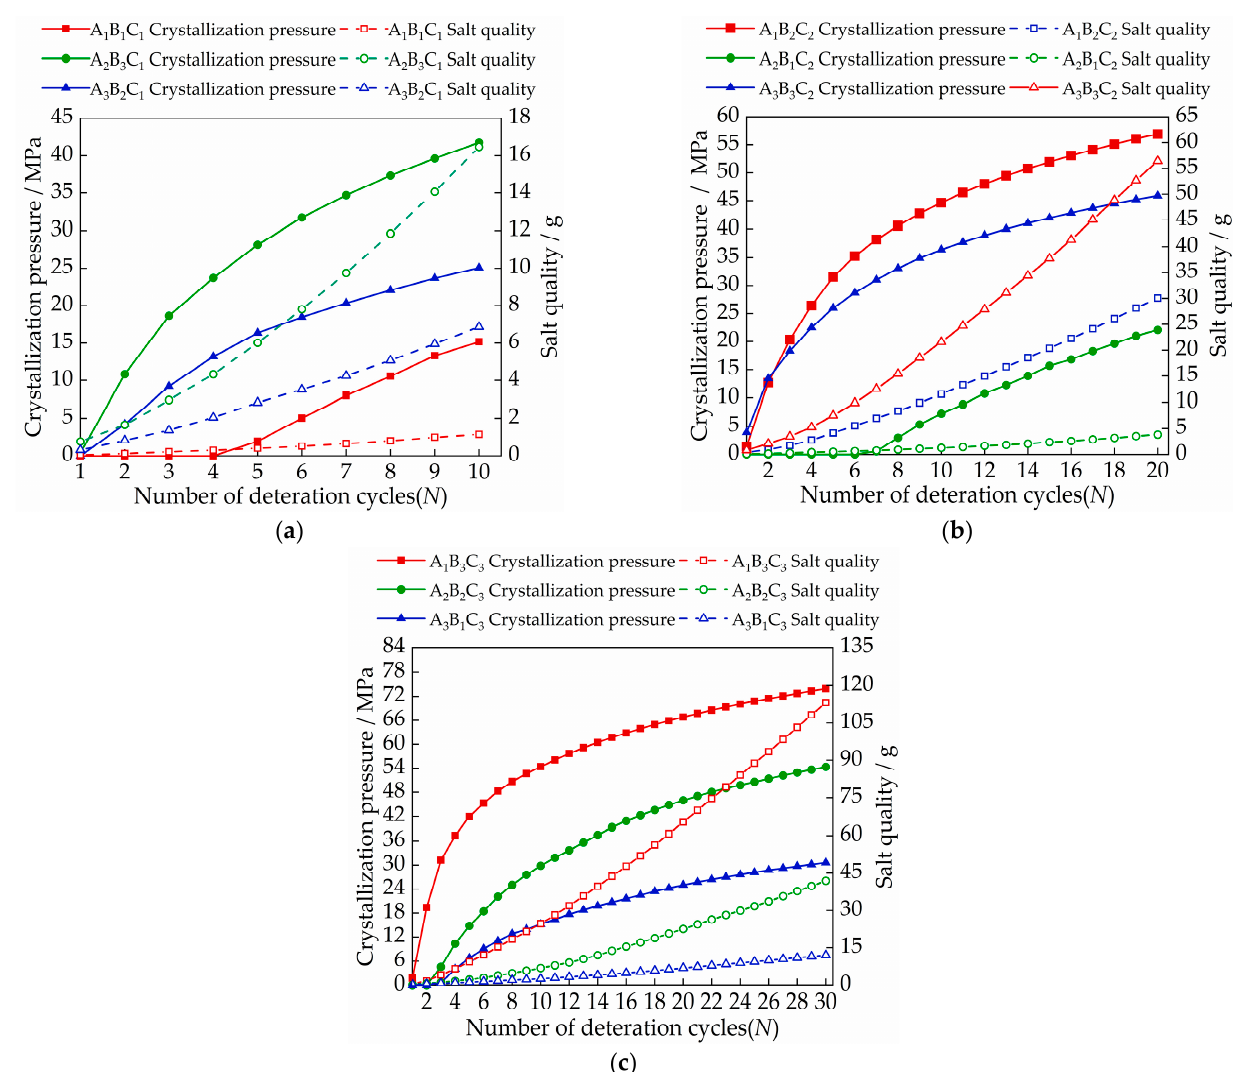
Figure 9. The internal crystallization pressure of each brick sample under different salt content and cycle times, where the salt quality refers to the mass of the solute in the solution inside the brick sample: ( a ) A 1 B 1 C 1 , A 2 B 3 C 1 , A 3 B 2 C 1 ; ( b ) A 3 B 3 C 2 , A 1 B 2 C 2 , A 2 B 1 C 2 ; ( c ) A 1 B 3 C 3 , A 2 B 2 C 3 , A 3 B 1 C 3 .